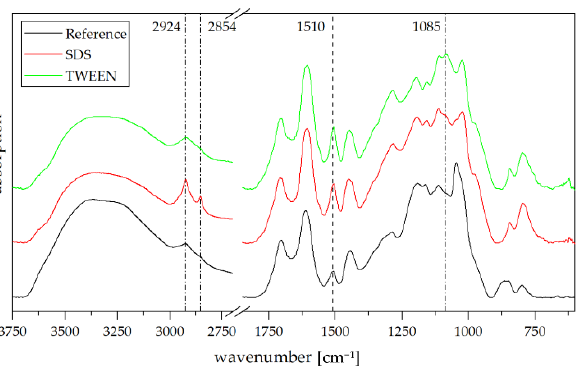
Figure 6. FT-IR spectra of rinsed SDS and TWEEN-based tannin foams. Classic tannin foam is given as reference.